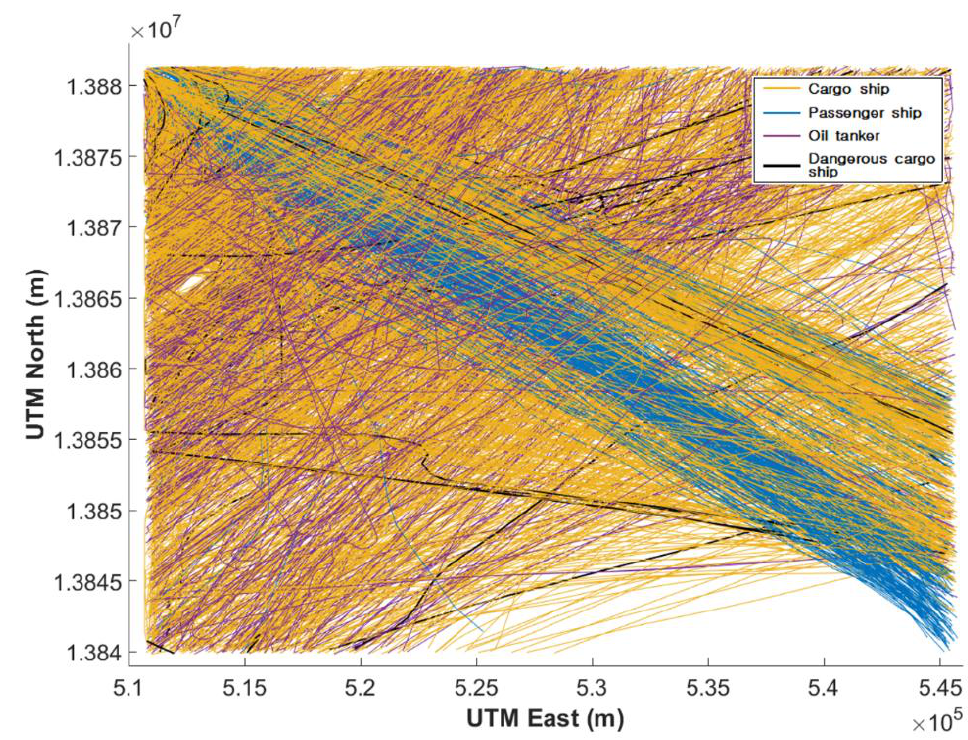
Figure 6. Total trajectories detected from the AIS data.